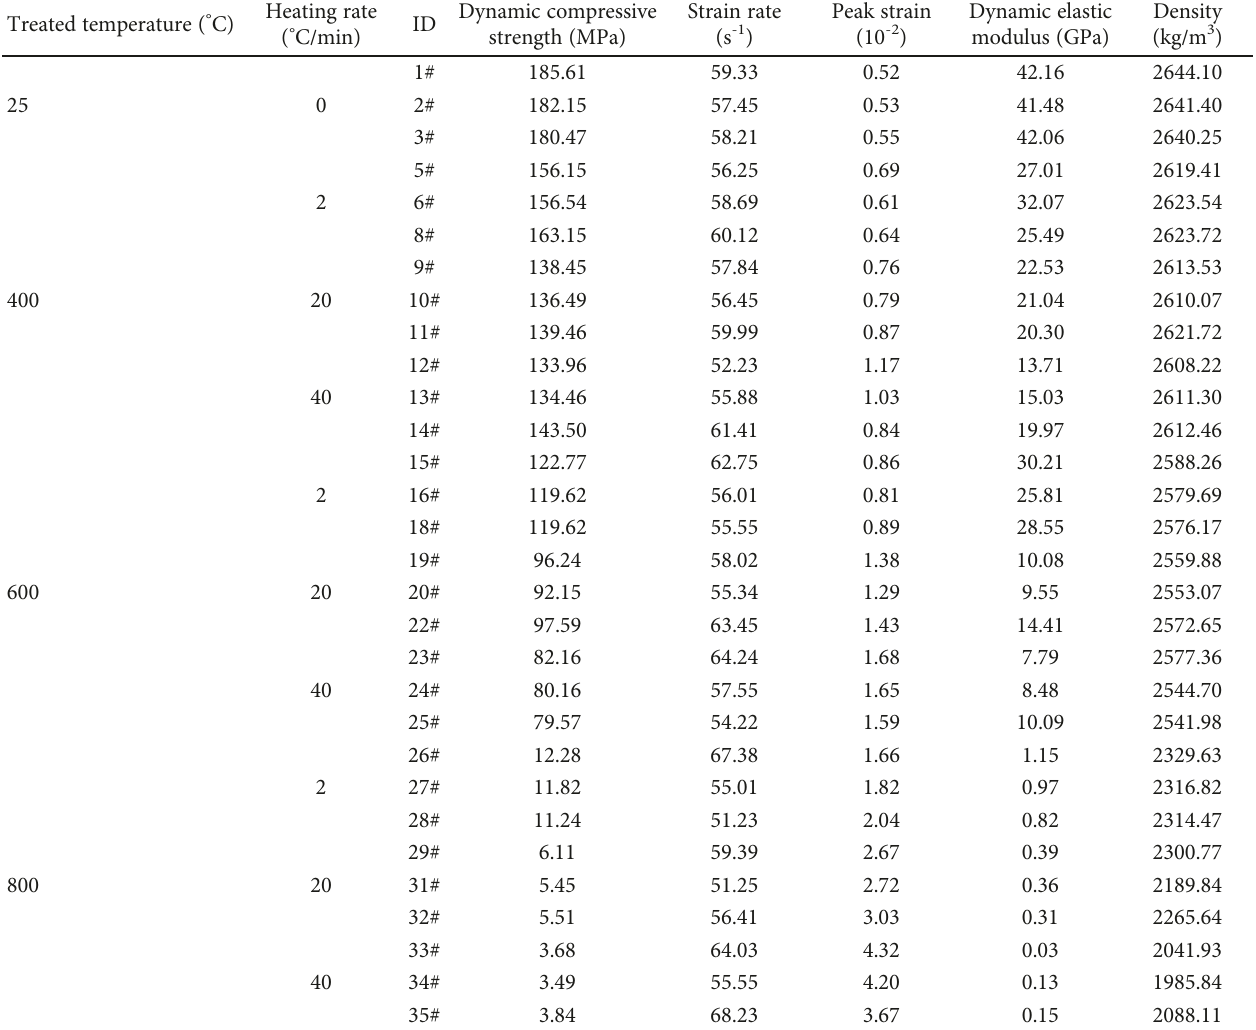
Table 2: Dynamic compressive and physical properties of granite after treatments at di ff erent heating rates and temperatures. Treated temperature ( °